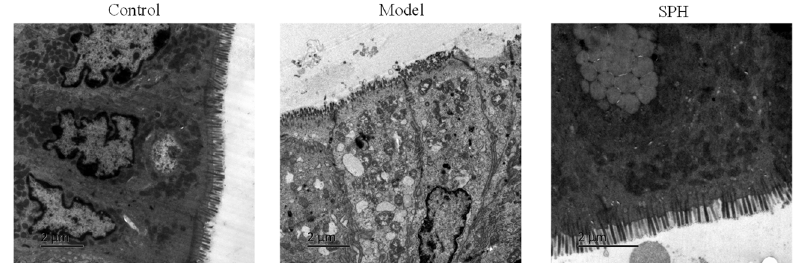
Figure 7. The transmission electron microscopy photos in colon section.